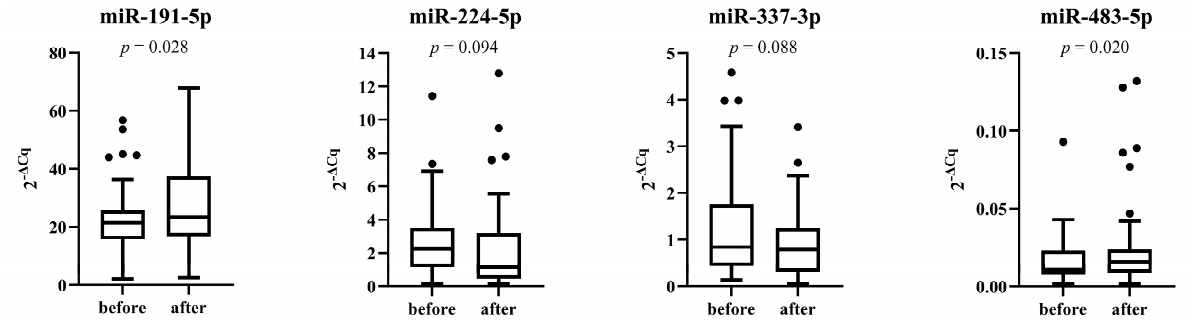
Figure 4. Expression of miRNAs before and after 6-month period of therapy with PCSK9 inhibitors.